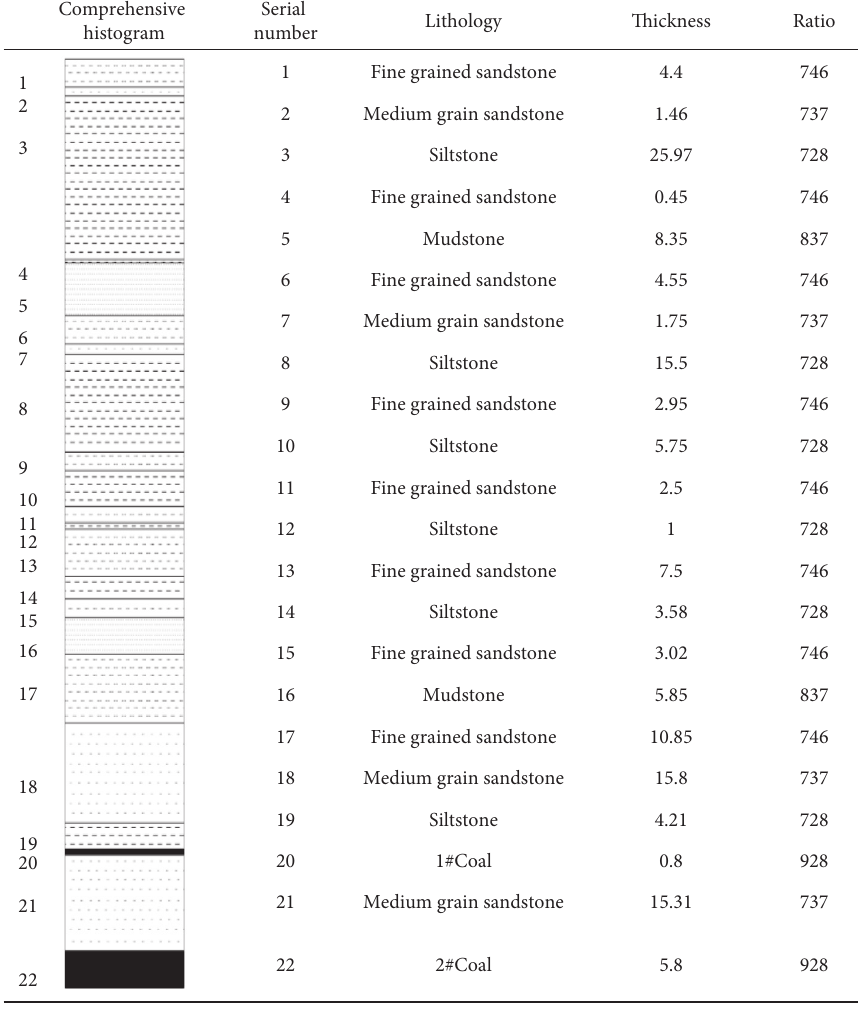
Table 1: The comprehensive histogram of coal and rock of working face.